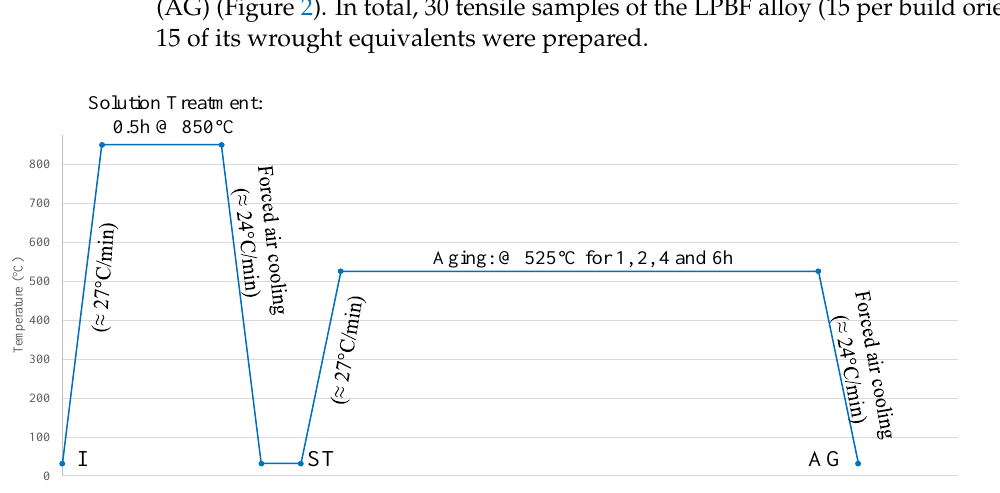
Figure 2. Heat treatment profile applied to the LPBF and wrought alloys: control points correspond to the initial (I), solution-treated (ST), and aged (AG) processing states.